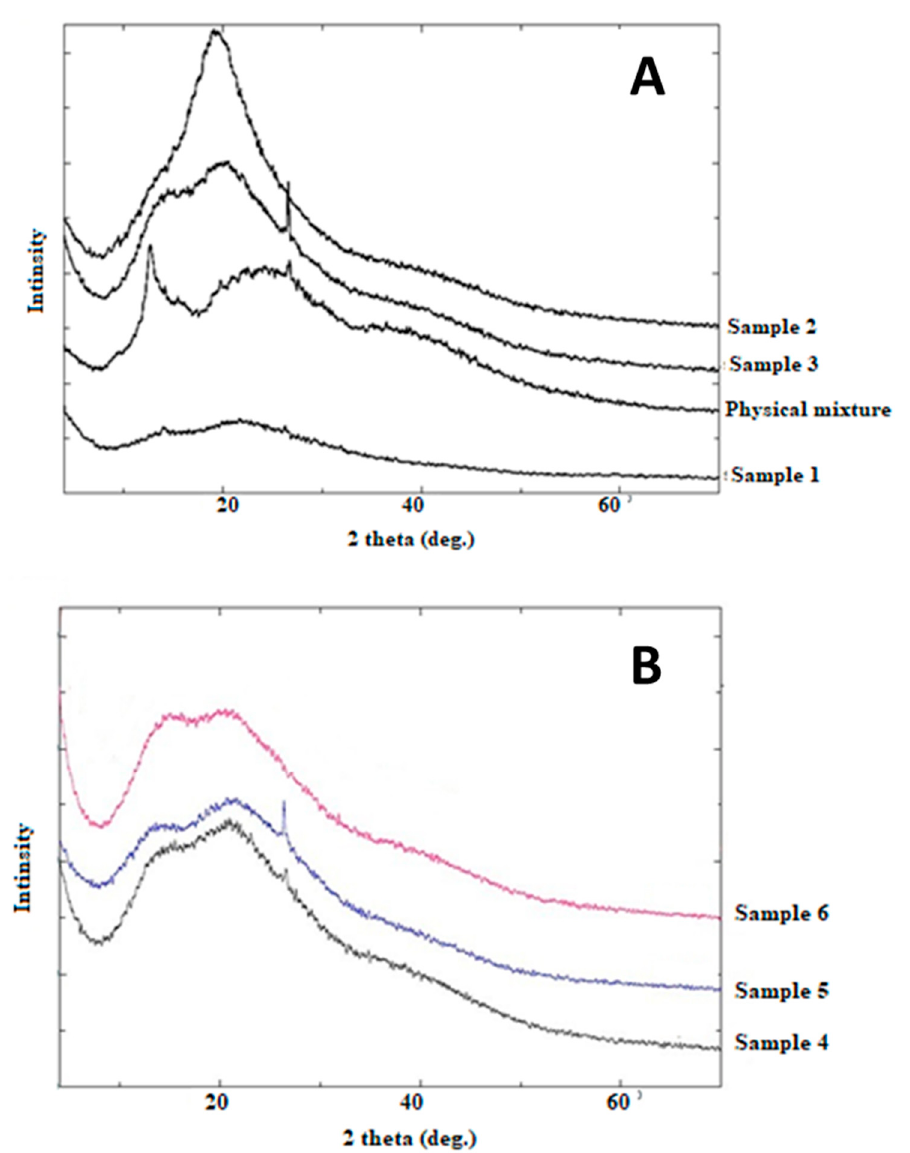
Figure 5. Powder X-ray di ff ractions of ( A ) Samples 1, 2, 3, and their corresponding physical mixture, ( B ) Samples 4, 5, and 6.